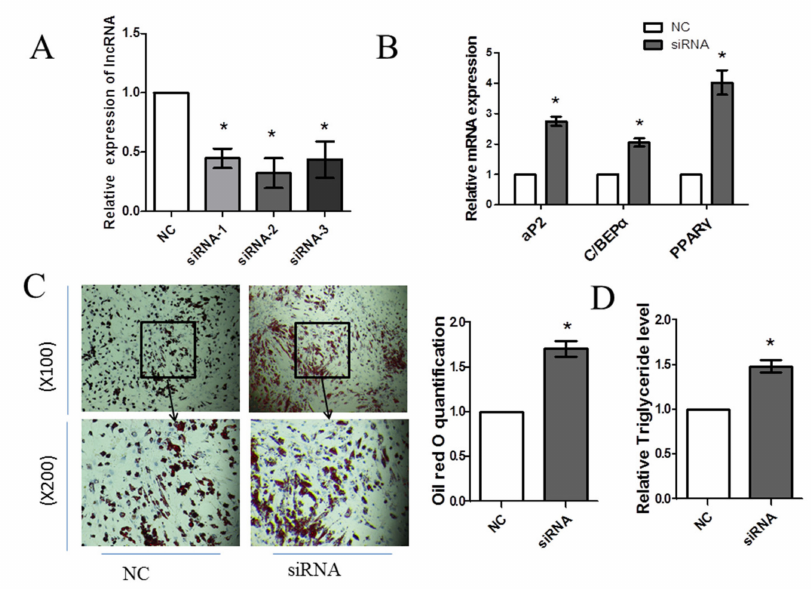
Figure 4. Knockdown of FDNCR1 promotes preadipocyte di ff erentiation. ( A ) Expression of FDNCR1 after transfection with FDNCR1 siRNA. ( B ) mRNA expression of aP2, C / EBP α , and PPAR γ after transfection with siRNA. ( C ) Oil red O staining (100 × , 200 × ) showing lipid accumulation. ( D ) Levels of triglycerides after transfection with siRNA. “*” indicates